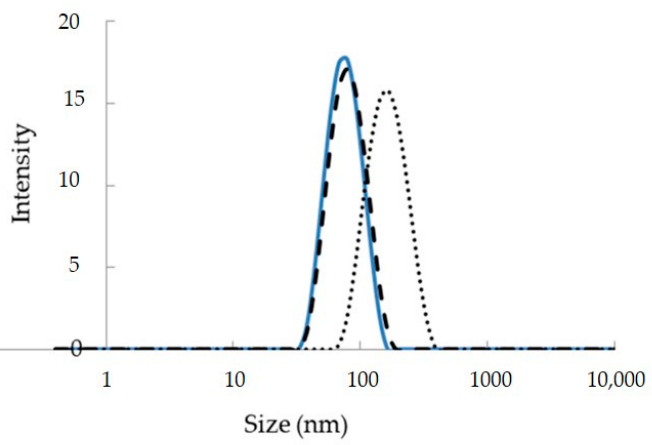
Figure 2. Droplet size distribution of empty and loaded L1 nanoemulsions. Encapsulation of vitamin D 3 and curcumin in low-energy o / w nanoemulsions based on water, IPM, Tween 80, Labrasol, Maisine and Transcutol (L1). ( ─ ): empty, (- - -): loaded with vitamin D 3 , (…): loaded with curcumin.